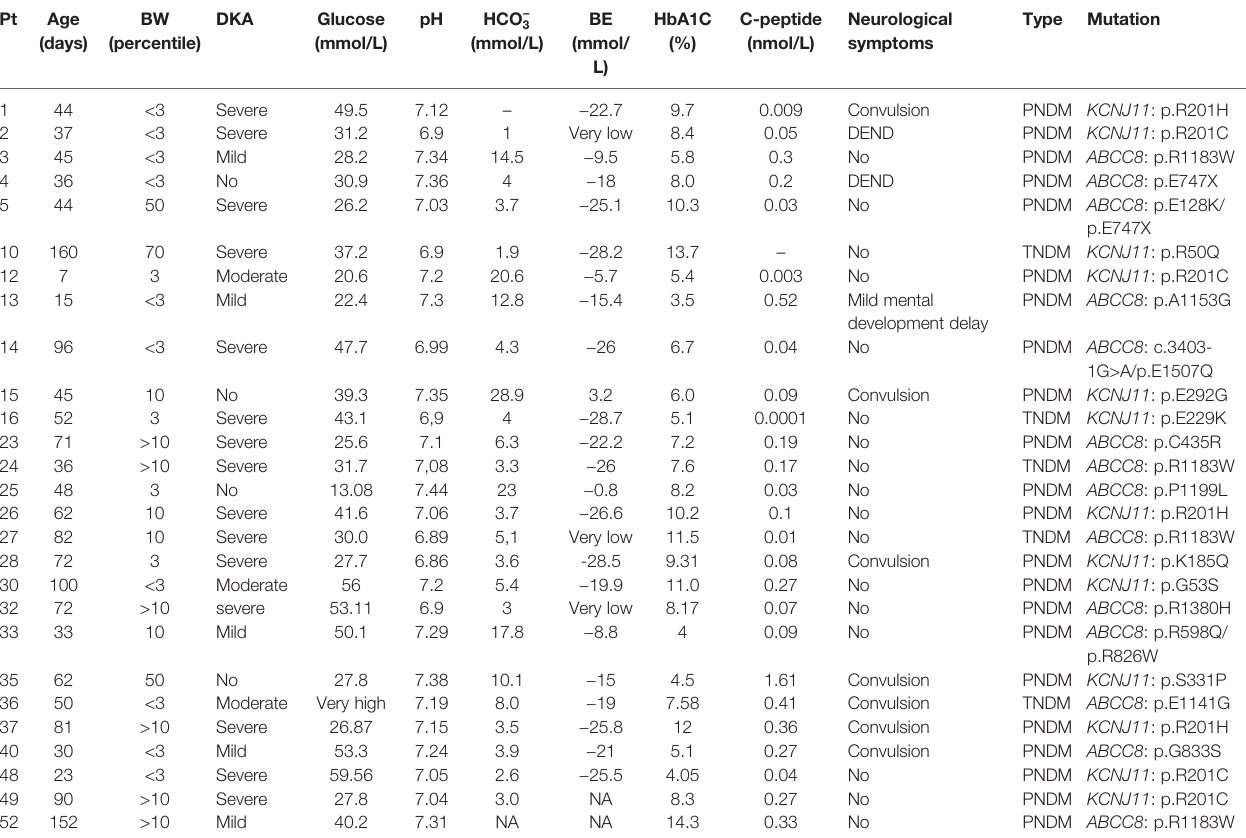
TABLE 1 | Clinical features of 27 NDM Vietnamese patients with KCNJ11 / ABCC8